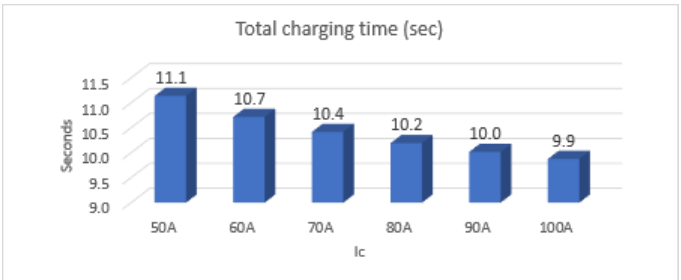
Figure 31. Diagrams of SC circuit charging durations in the case of a six-phase converter with ∆ V x = 0.6 V, ∆ D 0 = 25% at different constant currents.